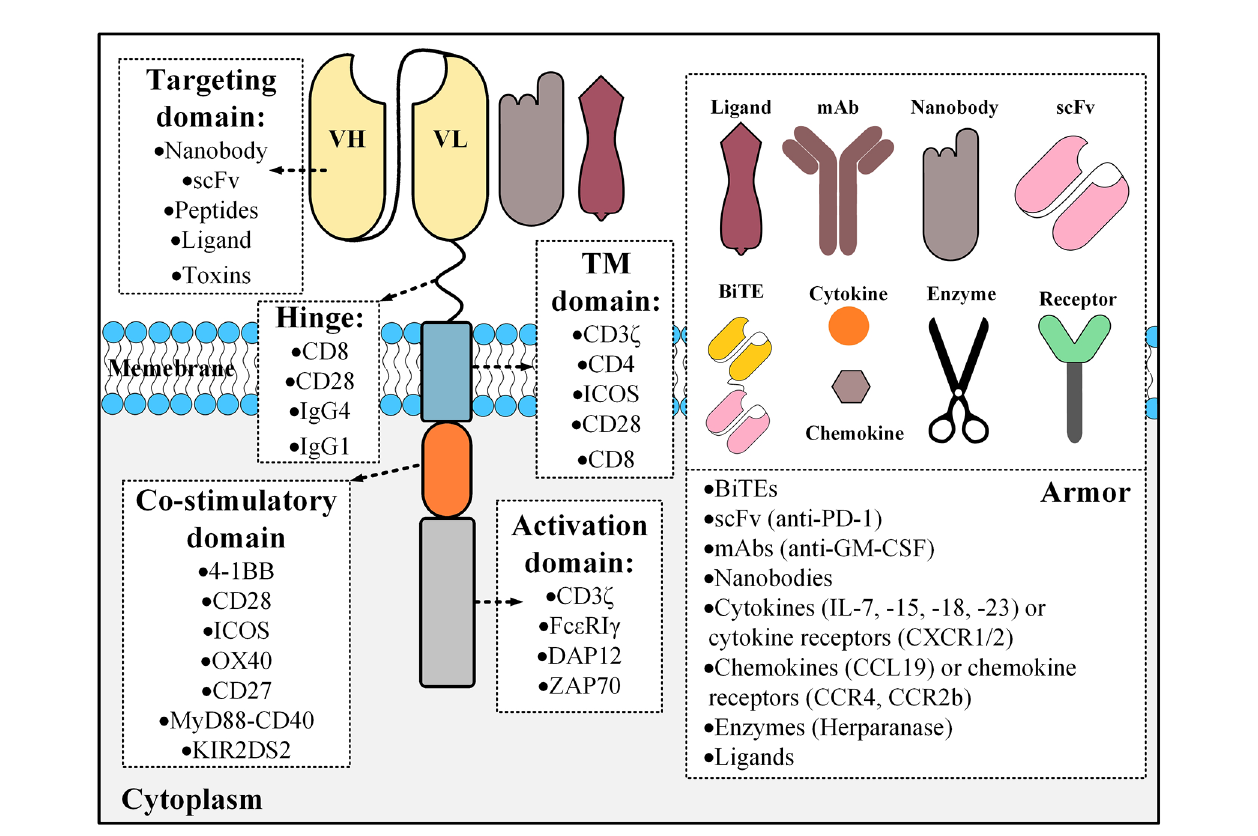
FIGURE 1 | The building blocks of a CAR molecule and examples of different components that could be used for its construction. CAR constructs can also be engineered for the expression of an “ armor ” molecule that can operate in different aspects including the modi fi cations of the tumor microenvironments, enhancing the homing of CAR T cells to the tumor site, or having immunomodulatory effects resulting in the augmentation of CAR T cell tumoricidal ef fi cacy. Different types of armors are shown in the right panel with examples in parentheses. BiTE, bispeci fi c T cell engager; TM, transmembrane; mAb, monoclonal antibody; scFv, single- chain variable fragment; ICOS, the inducible T cell co-stimulator; ZAP70, the z -chain of TCR-associated protein kinase 70